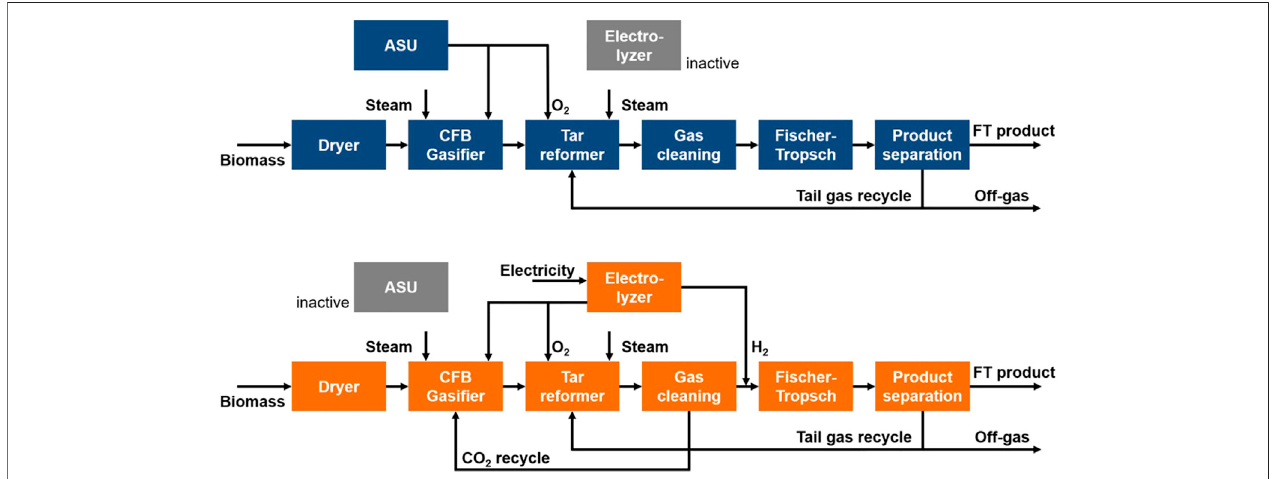
FIGURE 2 | Schematic fl ow diagram for the biomass alone operation mode (BA) (top) and electrolysis assisted mode (EA) (bottom)